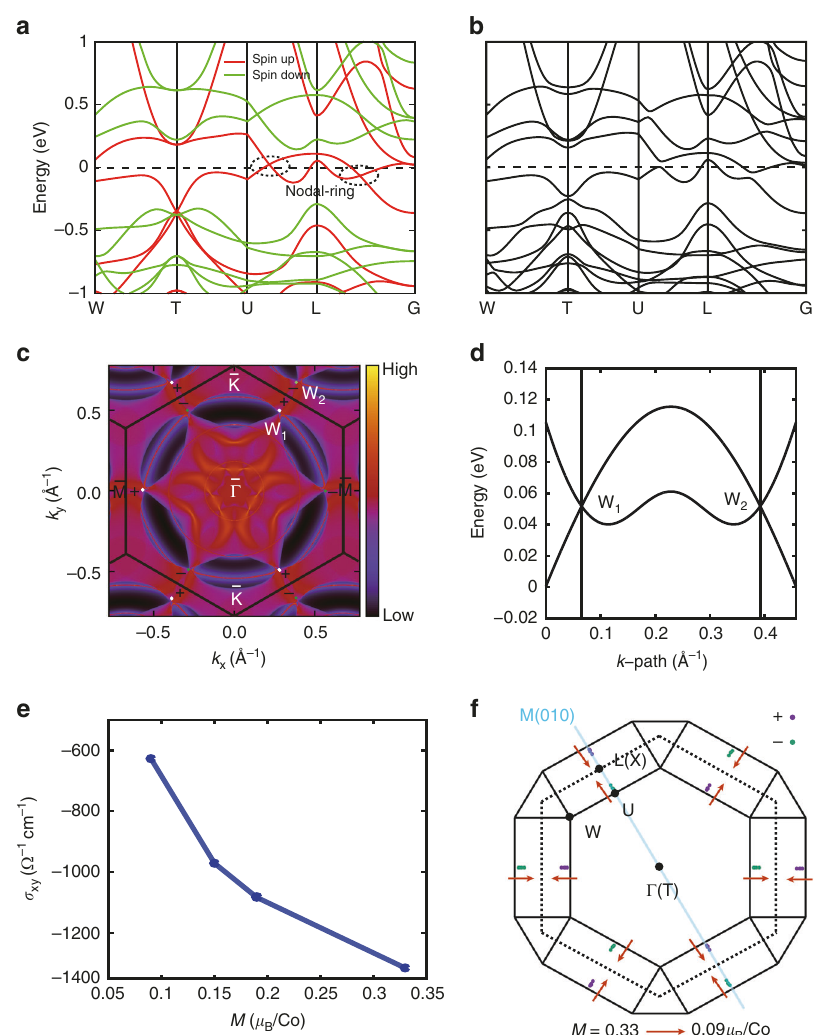
Fig. 2 Band structure obtained from fi rst-principle calculations. a The spin-resolved band structure without SOC. b The band structure with SOC included. The de fi nition of high-symmetry points are shown in Fig. 3a. c Fermi surface on the (001) surface cutting on the energy of WPs. The white and green dots represent the projected WPs with positive and negative chirality respectively. d The energy dispersion along the direction connecting the WPs W1 and W2 in c . e The intrinsic anomalous Hall conductivity with the magnetic momentum of 0.09, 0.15, 0.19, and 0.33 μ B /Co at 0 K. f The evolution of WPs in the BZ with the magnetic momentum decreased from 0.33 to 0.09 μ B /Co. The directions of the evolution are indicated by the red arrows. The E F is set to